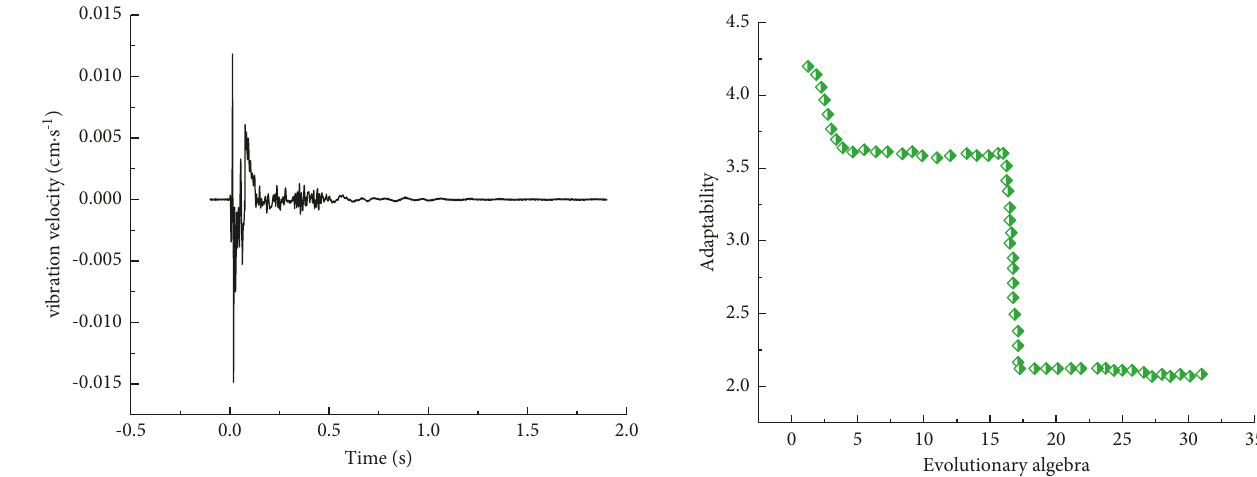
8: The change of the fitness function with the number of calculation steps. Table 1: Relevant training results of